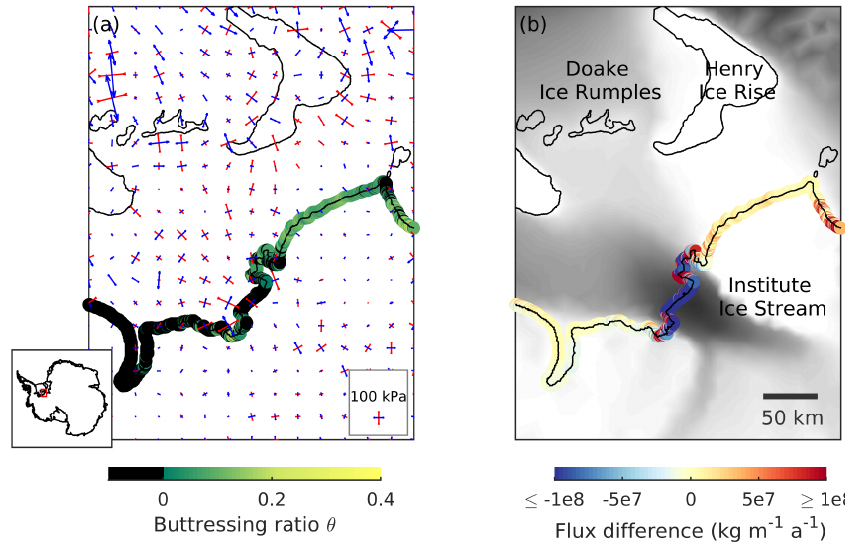
Figure 3. Buttressing ratio and differences in grounding-line flux for Institute Ice Stream draining into the Filchner–Ronne Ice Shelf (location shown in inset). (a) Buttressing values θ 1 are displayed along the grounding line and principle deviatoric stresses are shown with compression in red and extension in blue. The length of the vectors indicate the magnitude of each principle stress. (b) Differences between analytical and modelled fluxes and observed ice velocities ranging up to 500ma − 1 (Gardner et al., 2018). Analytical fluxes are set to 0 where θ 1 < 0. Grounding-line positions are indicated in